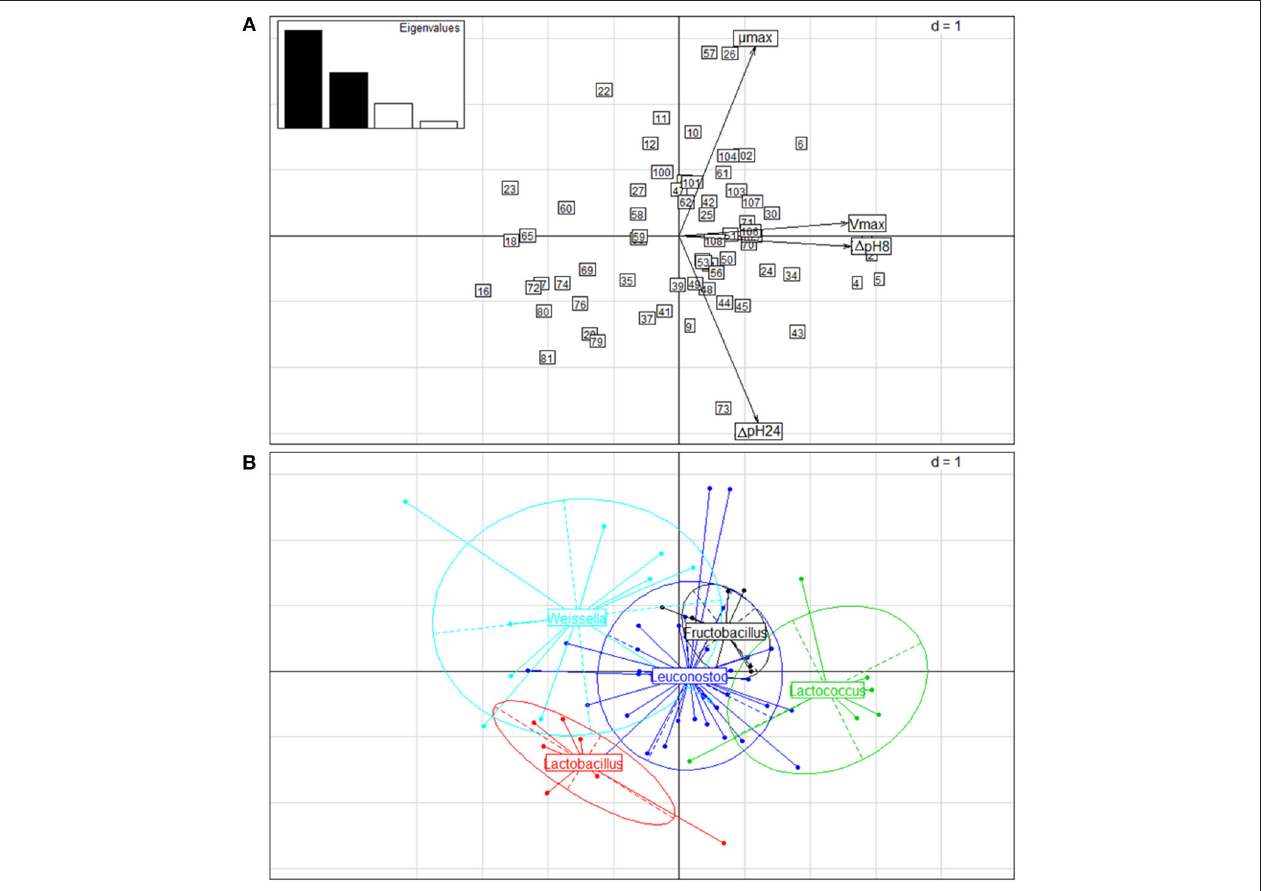
FIGURE 5 | Principal component analysis (PCA) of the kinetic parameters of 67 LAB strains isolated from wild fruits and flowers in Northern Argentina. (A) Biplot of PCA obtained considering 1 pH8, 1 pH24, V max and µ max of the strains grown in FSM medium at 30 ◦ C for 24h. Arrows correspond to eigenvectors for the kinetic parameters. The numbers of the strains correspond to the codes presented in Table 5 . (B) Biplot of the strain distribution obtained, considering the genus as classification